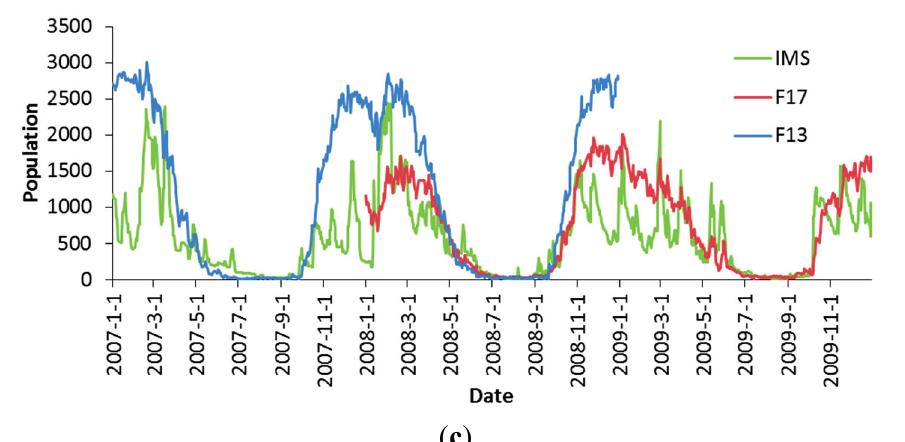
Figure 6. Population of snow-covered pixels from F17, F13 and IMS: ( a ) Northwest; ( b ) Northeast; and ( c ) QTP.